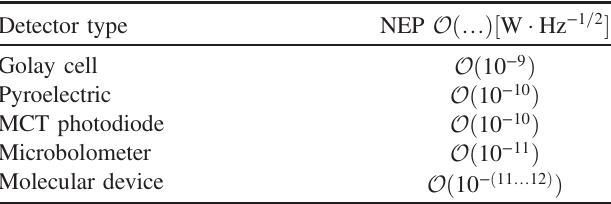
TABLE I. Noise-equivalent power of commercially available uncooled devices in the 5 – 50 THz region [4,5] and comparison with the device presented in this manuscript (molecular